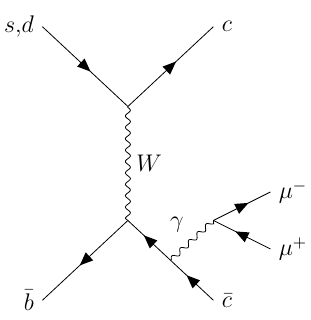
Figure 4: Feynman diagram for the decay. Figure 2 . Feynman diagram for B 0 , B 0 → J/ψ ( µ + µ − ) µ + µ − decays. s